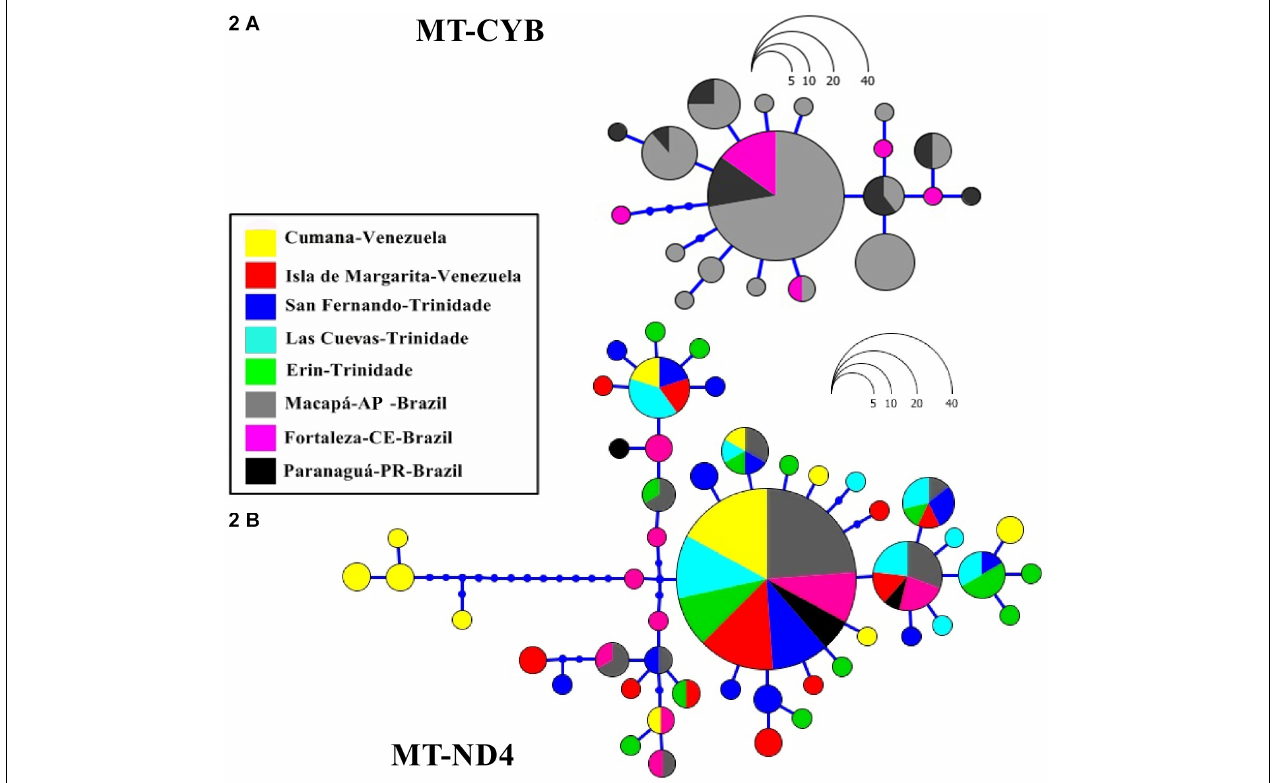
FIGURE 2 | Haplotype genealogies derived from the Maximum Likelihood analysis of the mitochondrial MT-CYB (A) and MT-ND4 (B) genes of Scomberomorus brasiliensis , run in the Haploviewer software, based on the HKY model. Each locality is represented by a different color, and each circle denotes a specific haplotype, the frequency of which is proportional to the scale shown. The length of the branches are also proportional to the number of mutations that separate the respective haplotypes.